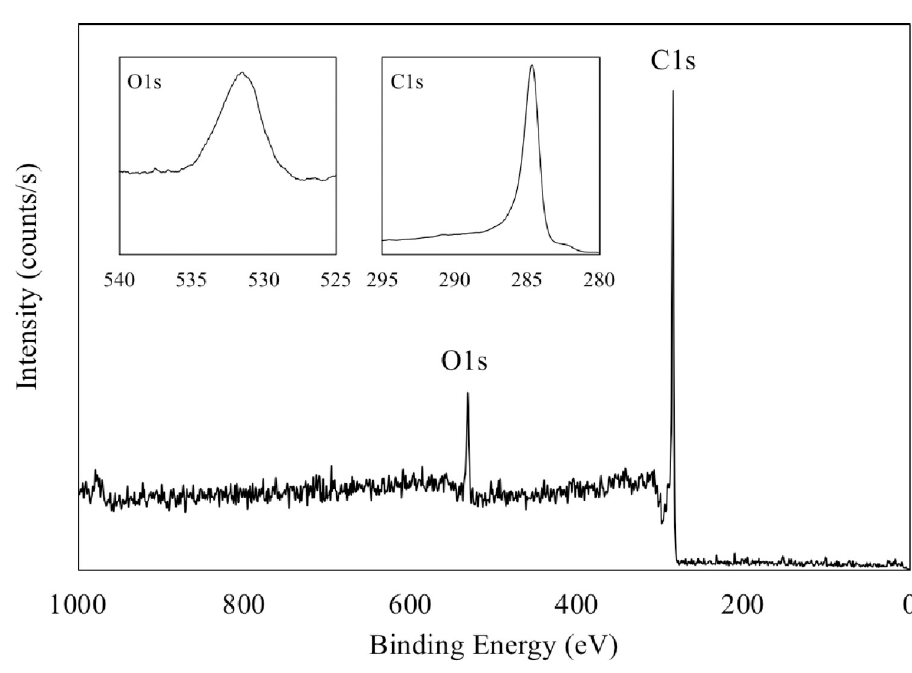
Fig 6. The survey spectrum of the coarse coffee powder.